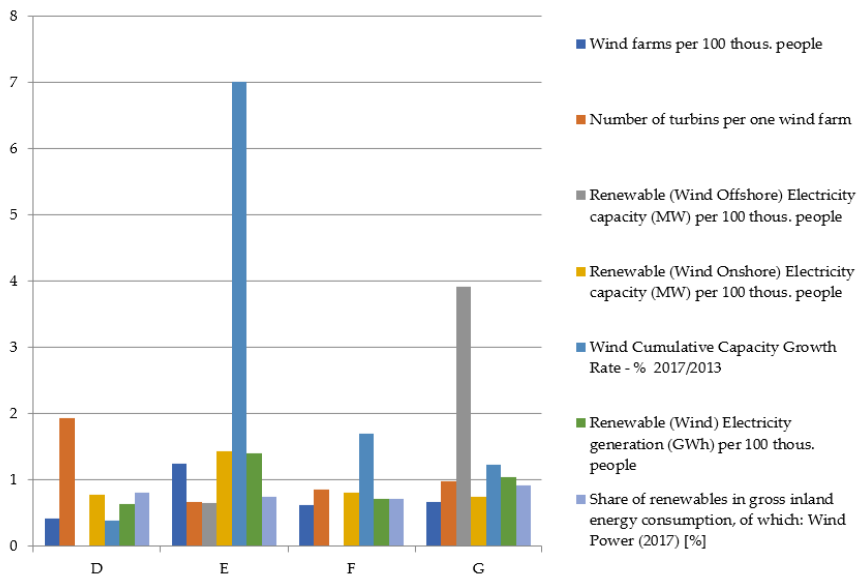
Figure 8. Group means for clusters included in cluster D from Figure 7.